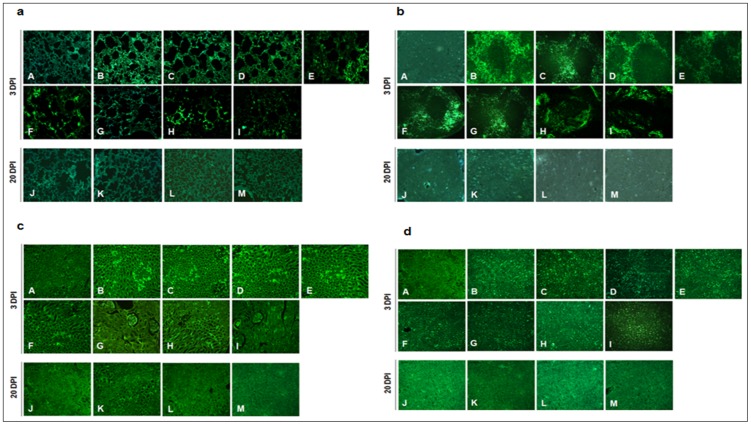
Immunohistochemistry (IHC) staining for localization of Y. pestis in the organs collected from immunized group animals on 3rd and 20th day post infection with Y. pestis and the naive control animals that were neither immunized nor challenged.The F1 antigen of Y. pestis was identified with anti-mouse FITC conjugated secondary antibody in the tissue sections collected from immunized animal groups on 3rd day post infection including naive control i.e., Naive control (A); PBS control (B); HSP70(II) (C); F1 (D); F1+HSP70(II) (E); LcrV (F); LcrV+HSP70(II) (G); F1+LcrV (H); F1+LcrV+HSP70(II) (I). Tissue sections were collected from the survived animal groups on 20th day post infection i.e., LcrV (J); LcrV+HSP70(II) (K); F1+LcrV (L); F1+LcrV+HSP70(II) (M). Fluorescent images representing the localization of Y. pestis in tissue sections of Lung [a]; Spleen [b]; Kidney [c]; and Liver [d].